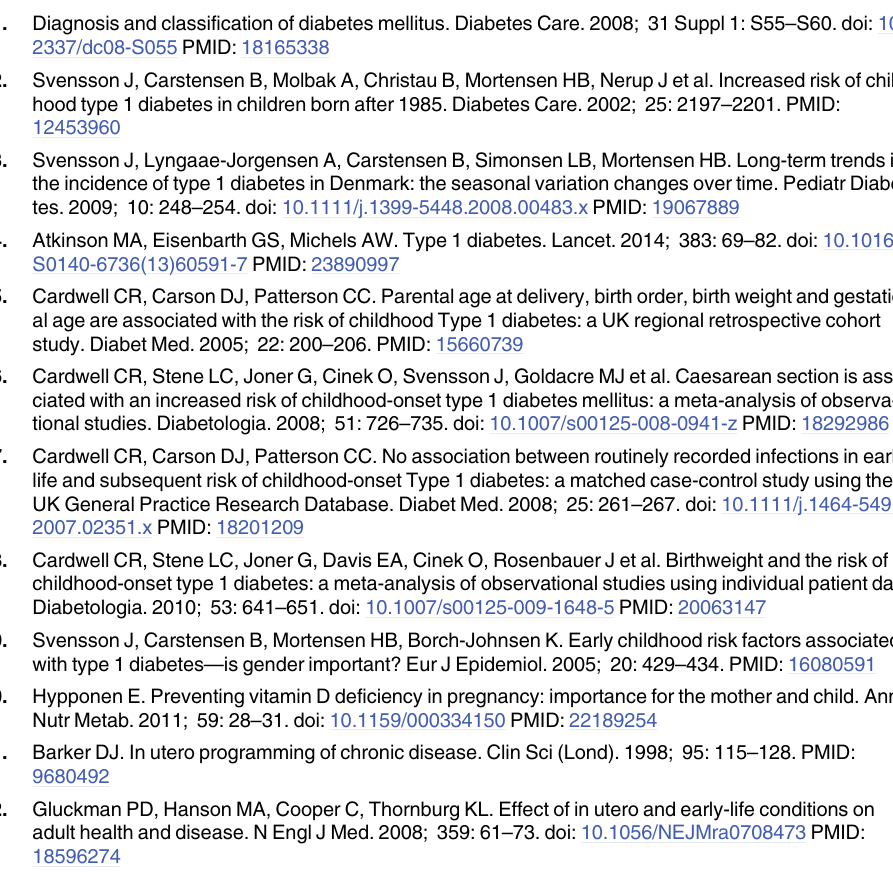
S2 Table. Slopes (95% CI) for linear increase in T1D incidence for individuals during vari- ous periods of first postnatal year exposure to vitamin D fortification by age at T1D diag- nosis. The slopes, or regression coefficient, are expressed in log HR per month of birth; all adjusted for sex, in italic — adjusted for sex and cumulative 1 st postnatal year sunshine. 1 Ad- ministratively censored at age of 5; 2 administratively censored at age of 10 and truncated be- fore age of 5; 3 truncated before age of 10; 4 including the starting and ending